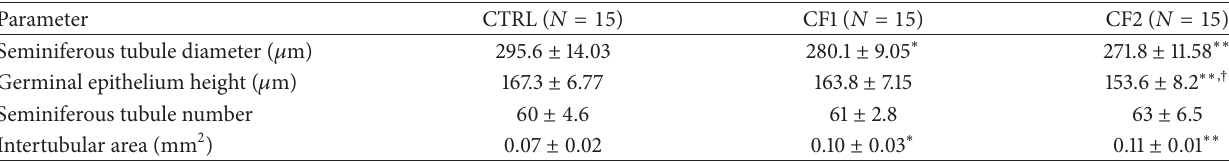
Table 1: Histomorphometric parameters analyzed in the testes of the control and caffeine-fed groups. Parameter CTRL ( 𝑁 = 15 ) CF1 ( 𝑁 = 15 ) CF2 ( 𝑁 = 15 ) Seminiferous tubule diameter ( 𝜇 m) 295.6 ± 14.03 280.1 ± 9.05 ∗ 271.8 ± 11.58 ∗∗ Germinal epithelium height ( 𝜇 m) 167.3 ± 6.77 163.8 ± 7.15 153.6 ± 8.2 ∗∗,† Seminiferous tubule number 60 ± 4.6 61 ± 2.8 63 ± 6.5 Intertubular area (mm 2 ) 0.07 ± 0.02 0.10 ± 0.03 ∗ 0.11 ± 0.01 ∗∗ Values are expressed as mean ± SD. ∗ 𝑝 < 0.01 , ∗∗ 𝑝 < 0.001 versus CTRL; † 𝑝 < 0.01 CF1 versus CF2. CTRL: control; CF1: caffeine 120mg/kg/day; CF2: caffeine